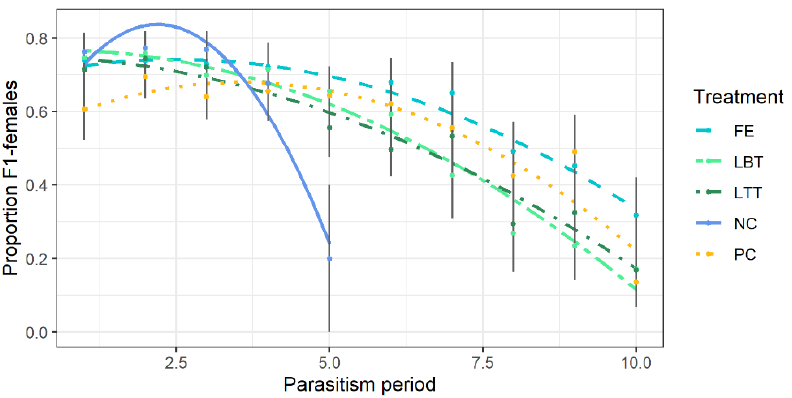
Figure 4. Proportion of females in offspring of Trichopria drosophilae fed with various diets (NC = water, negative control, PC = honey, positive control; flowers of FE = Fagopyrum esculentum , LBT = Lobularia maritima ‘Benthamii’, LTT = L. maritima ‘Tiny Tim’) up to the tenth parasitism period (= 23 days of female age). Solid dots display mean ± SE (grey lines). Parasitism period refers to 2.3 days on average.